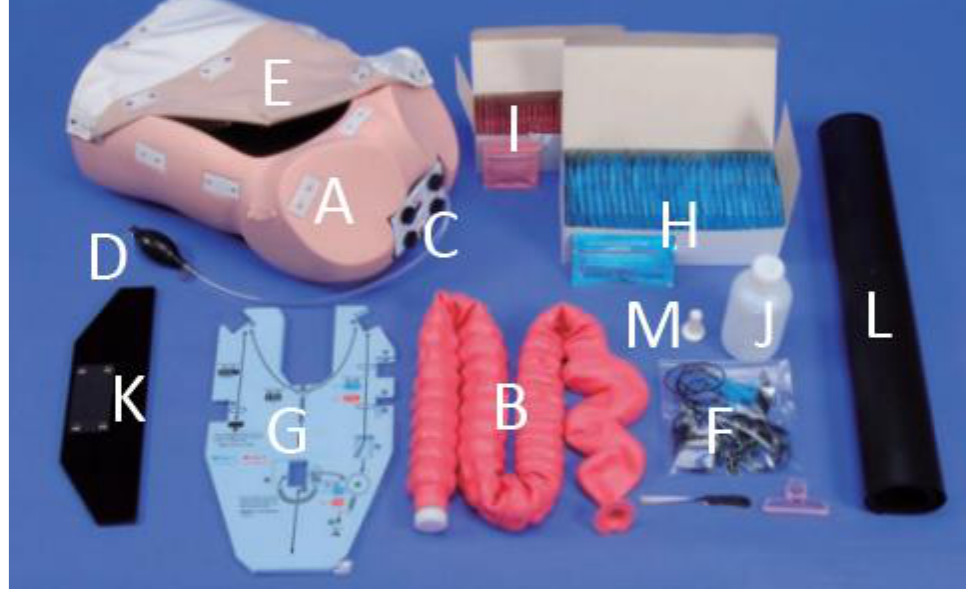
Figure 4. Components of the dummy for the experiment. A — Abdomen model; B — Colon – rectum tube; C — Anus unit; D — Air bulb; E — Abdomen skin cover; F — Colon tube fixtures; G — Colon